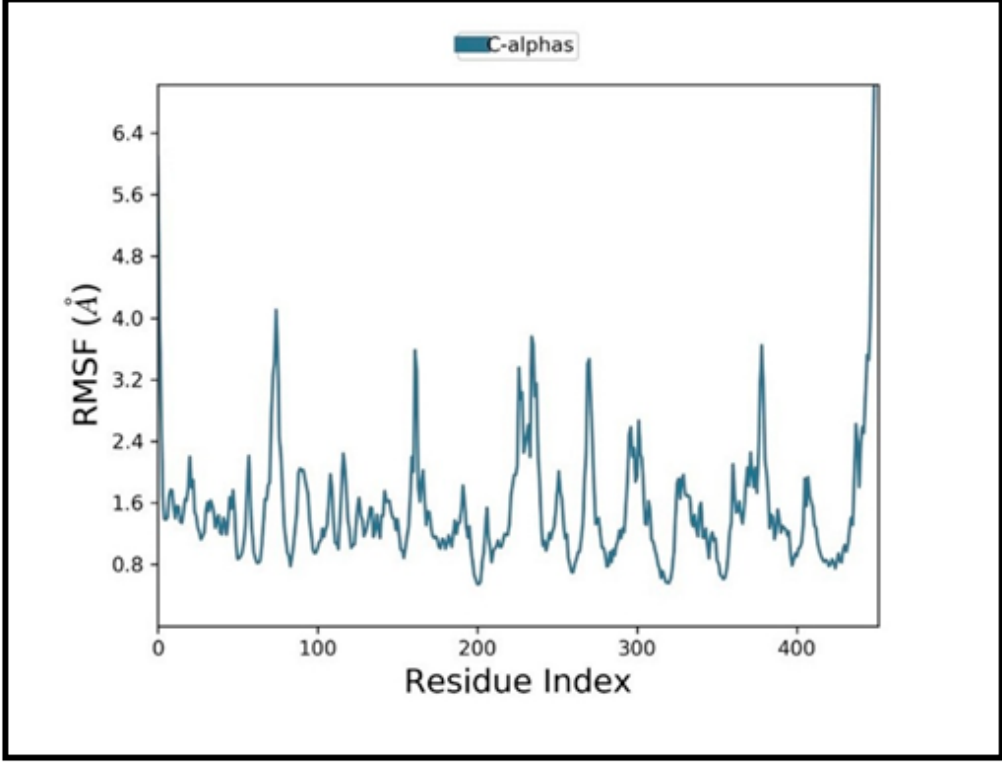
Figure 4. Root mean square fluctuation (RMSF) plot.